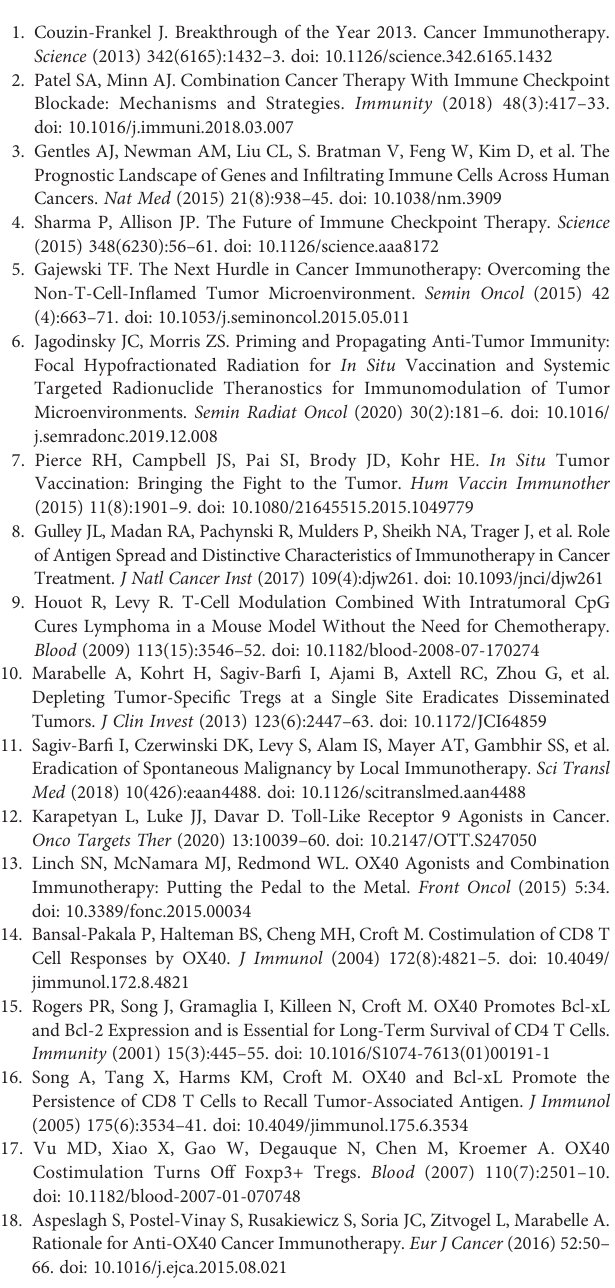
Supplementary Figure 3 | The fl ow cytometry gating strategy used in FlowJo to quantify OX40 MFI for Tregs and CD4+ non-Tregs ( Figures 2A, B ) and tumor Treg frequency ( Supplementary Figure 2A ). Supplementary Figure 4 | (A) The fl ow cytometry gating strategy used in FlowJo to quantify OX40 MFI on CD4+ T cells (Tregs and non-Tregs) and the ratio of effector cellstoTregcellsintheTMEfor Figures5A – C . (B) RepresentativedotplotsofCD4vs CD8 TILs from groups treated with PBS, CpG+OX40, RT, and RT+CpG+OX40.